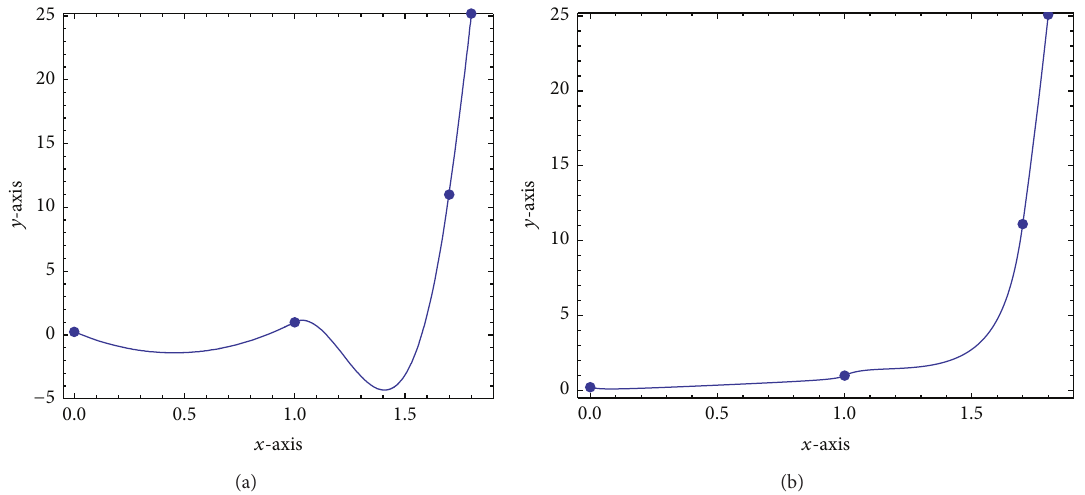
Figure 1: Comparison of (a) cubic Hermite spline curve and (b) our rational cubic spline with 𝛼 𝑖 = 𝛽 𝑖 = 0.5 .